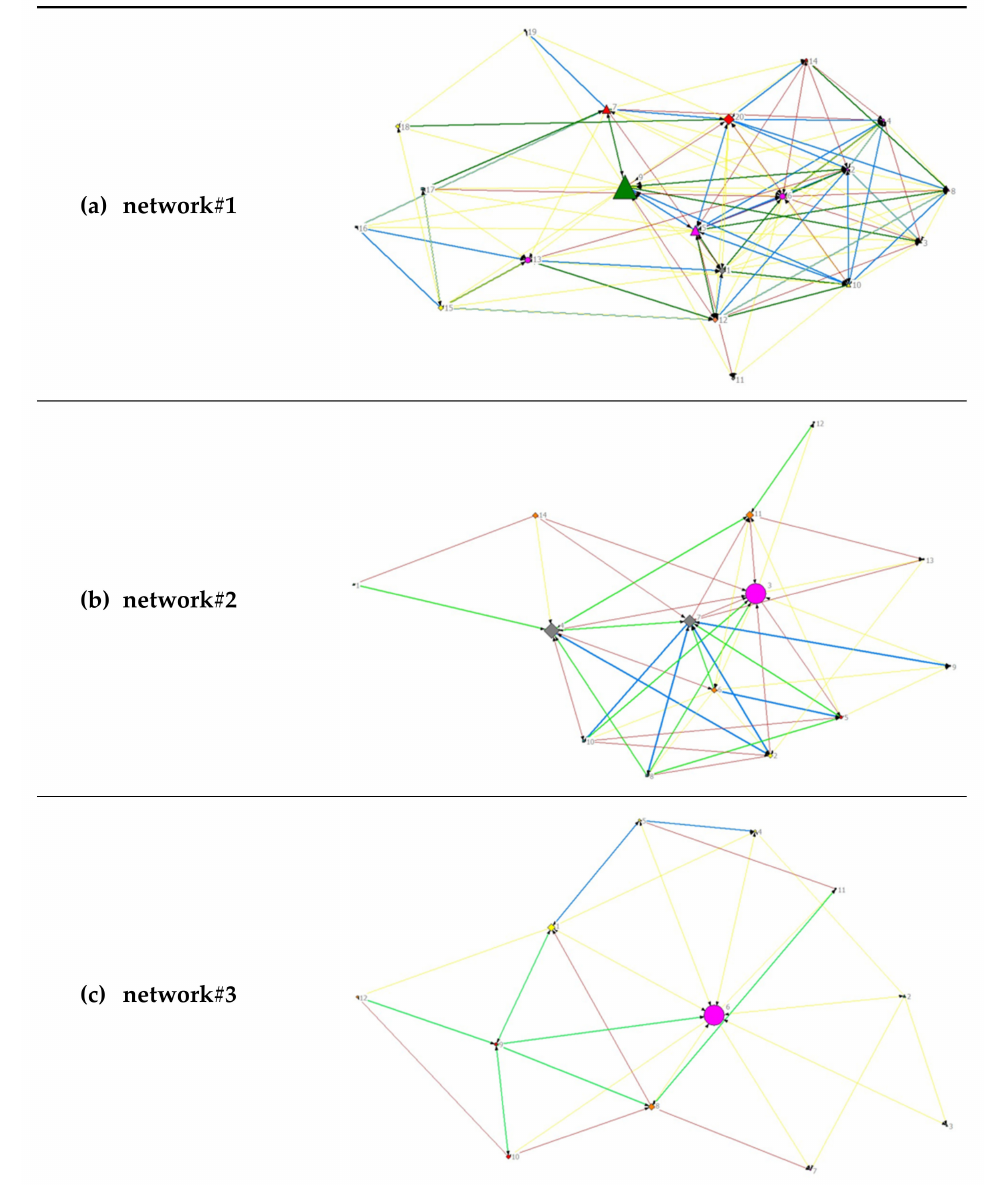
Figure 6. Visualization of network data regarding intensity of collaboration separately for ( a ) net- work#1, ( b ) network#2 and ( c ) network#3. Node size by betweenness. Intensity of collaboration: no color, no collaboration; red, sharing of information; yellow, informal collaboration to achieve common goals; green, collaboration as a team with specific responsibilities; blue, collaboration as a formal team (joint planning/sharing of